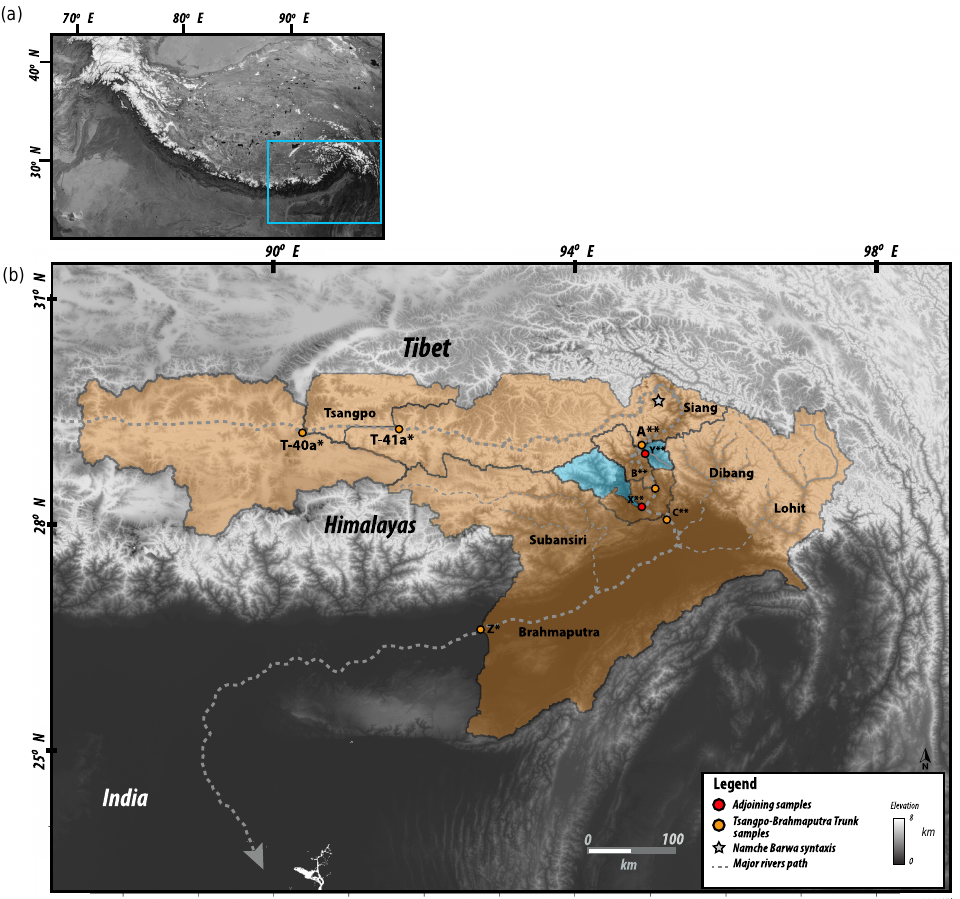
Figure 6. (a) Location of the study area and (b) location and name of sampling sites and geometry of the drainage basins contributing to each site. The orange shading represents catchments draining directly into the main trunk; pale blue shading represents the tributary catchments or